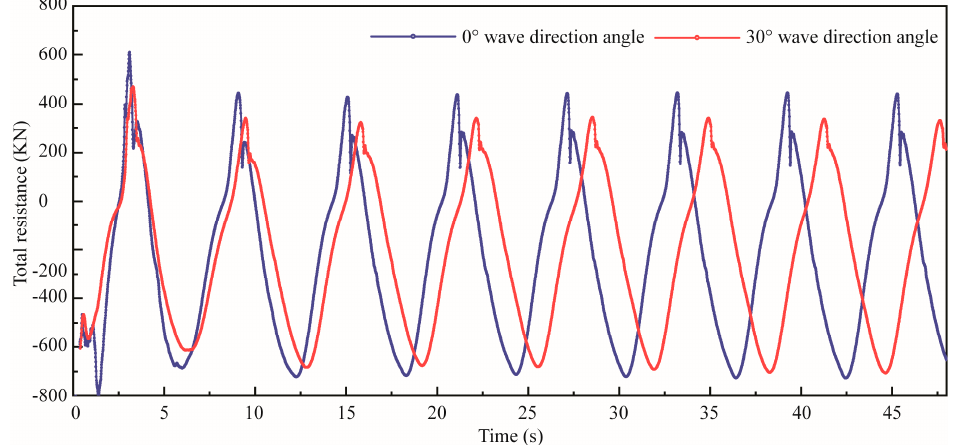
Figure 19. The total resistance in different wave directions with 5 level sea state.